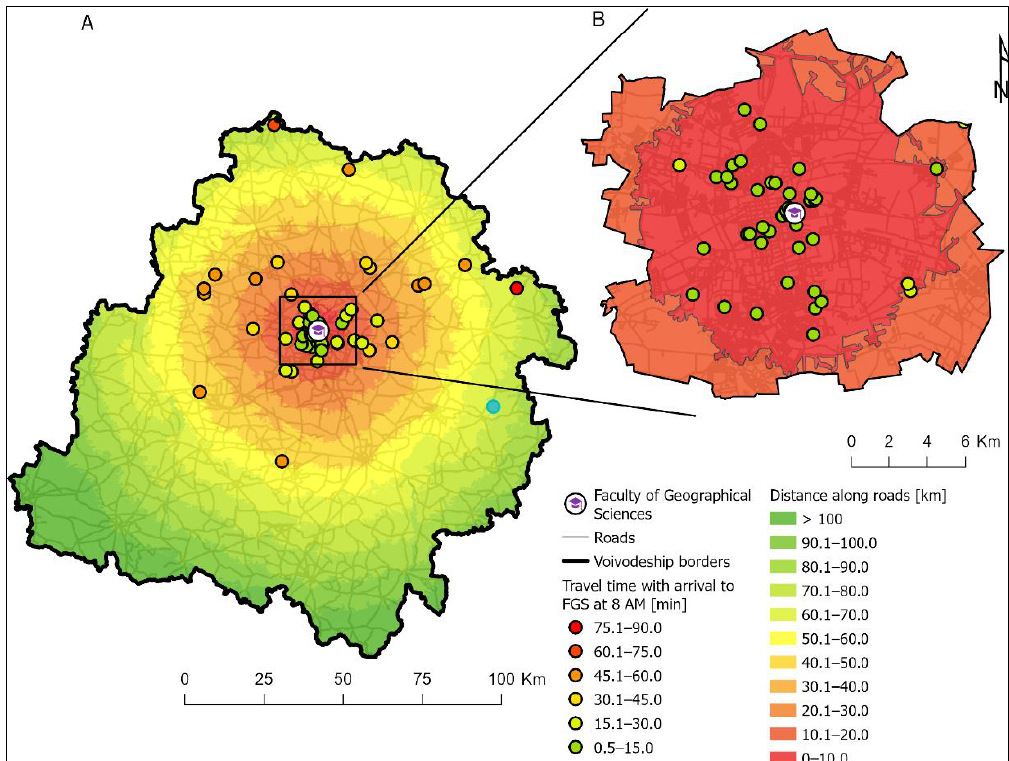
Figure 4. Communication accessibility of the Faculty of Geographical Sciences and the travel time of the students from their places to residence to the faculty in ( A ) Lodzkie voivodeship, ( B ) Łódź City.